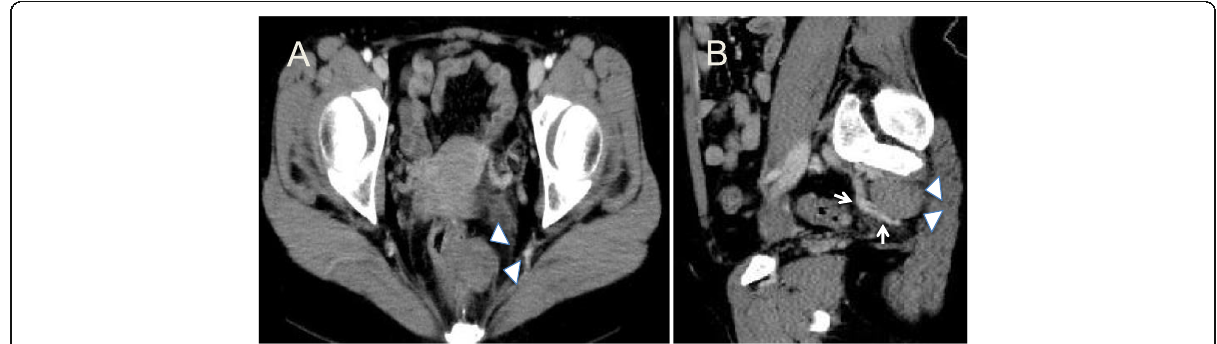
Fig. 2 Contrast-enhanced computed tomography. a The multilocular cystic lesion has a diameter of approximately 32 mm, and no enhancing solid components or calcifications are visible (white arrowhead). b The blood supply arises from the middle sacral artery (white